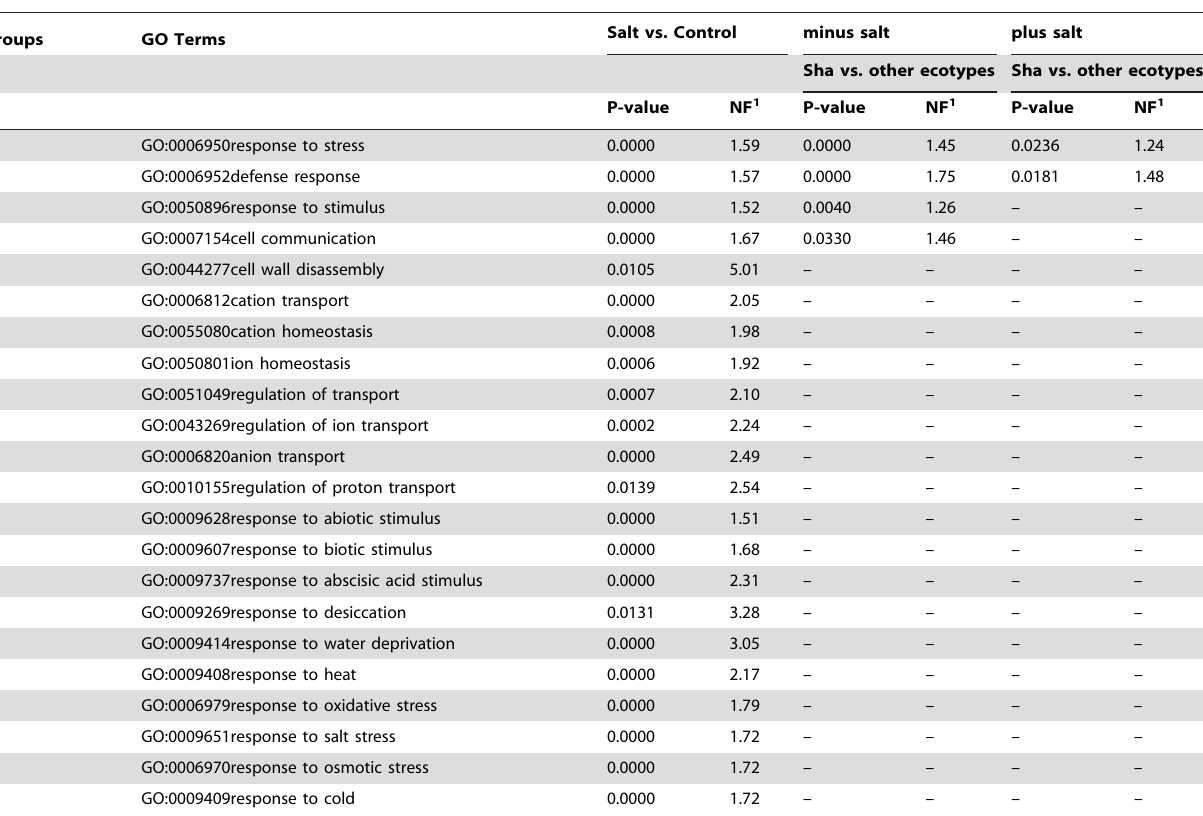
Table 2. Stress-related GO term enrichment analysis.